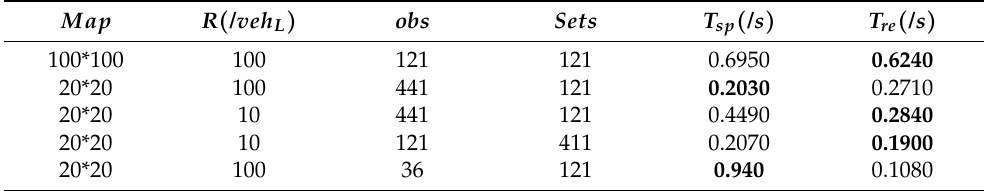
Table 4. This table shows a comparison between the scapegoat tree and KD tree reconstruction replanning methods. Map refers to the size of the original terrain map; R refers to the radius in which expected points are located; obs refers to the number of points this obstacle contains; sets refers to the number of potential expected points; T sp refers to the time cost of scapegoat; T re refers to the time cost of reconstruction treTree .